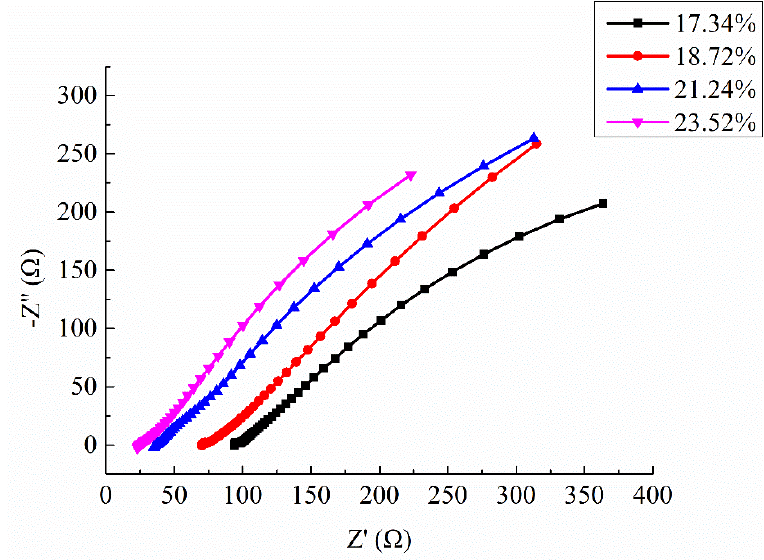
Figure 10. Nyquist diagram of di ff erent porosity mortar